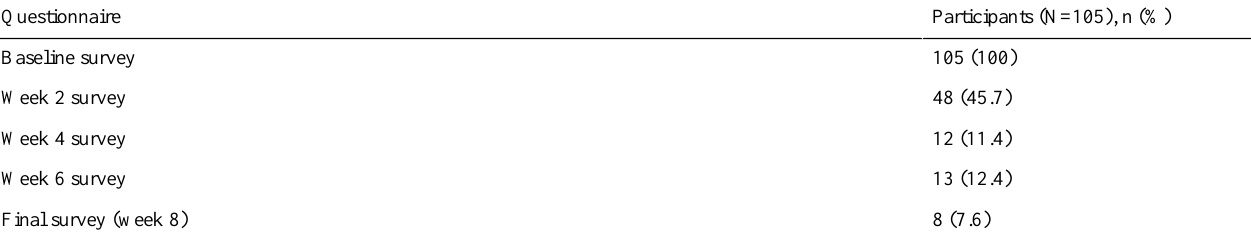
Table 2. Participant demographics and response